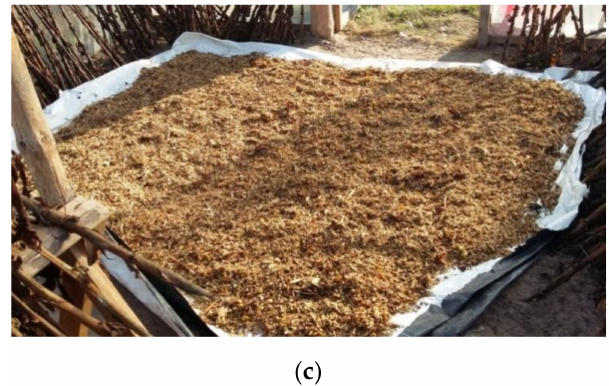
Figure 2. Post-harvest tobacco waste (stalks): ( a ) after-harvesting tobacco, ( b ) during pre-drying and ( c ) milled and pre-dried (own